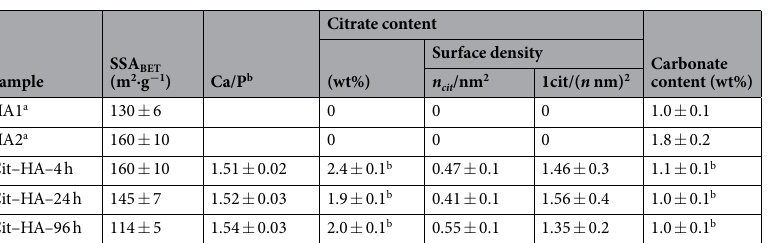
Table 1. Specific surface area (SSA BET ), Ca/P ratio, citrate and carbonate content of samples synthesized in the absence (HA) and presence of citrate (cit-HA) at different maturation times. The citrate surface density is also provided, as both n cit /nm 2 and 1cit/( n nm) 2 . a Citrate-free hydroxyapatite studied in ref. 26. b ref.